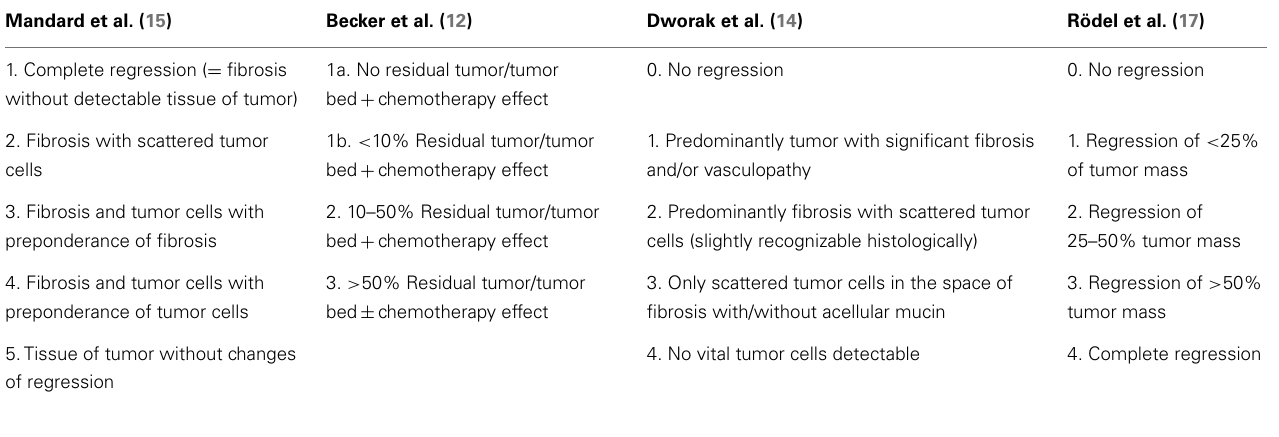
Table 1 | Examples for tumor regression grading